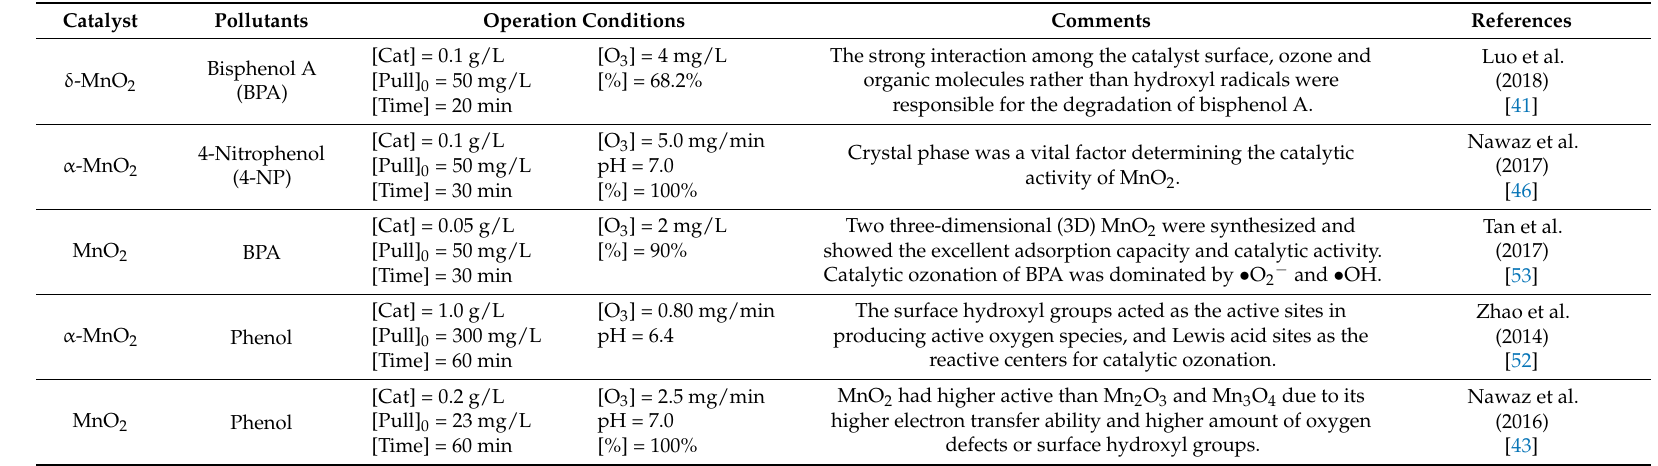
Table 3. Manganese oxide for catalytic ozonation